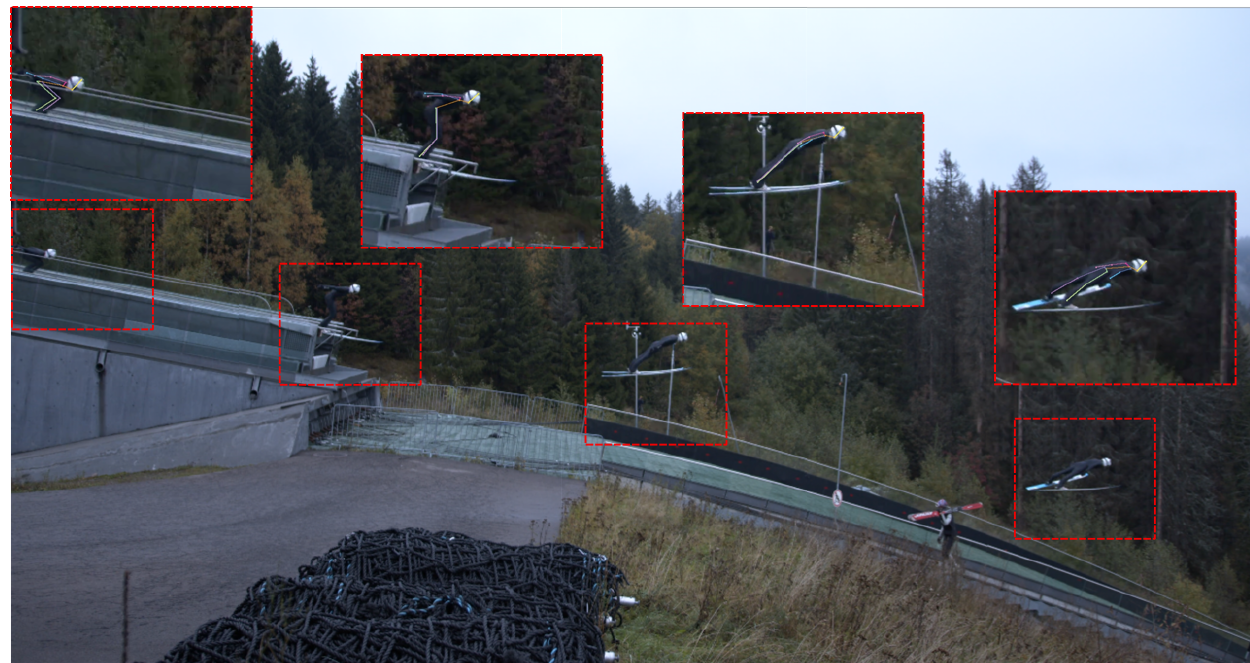
Figure 1. Camera view for the experiment together with examples of the cropped and tracked windows during the in-run, take-off and flight